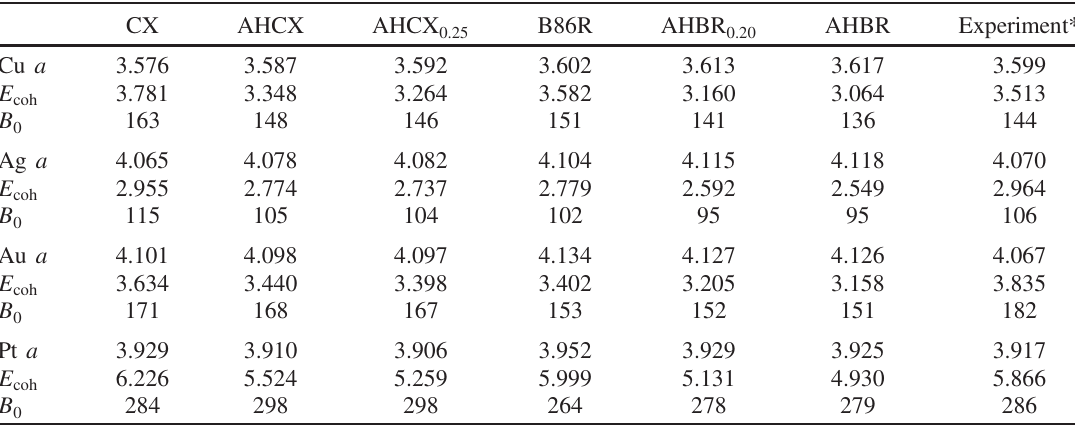
TABLE I. Comparison of vdW-DF performance on Pt- and noble-metal structure and elastic response: Lattice (in eV), and bulk moduli B 0 (in GPa). The Supplemental Material [62] constants a (in Å), cohesive energies E coh gives full listings for our computed a , E , and B 0 results for these transition metals and nine other materials. coh Experimental values back-corrected for vibrational effects (as indicated by an asterisk) are taken from Ref.